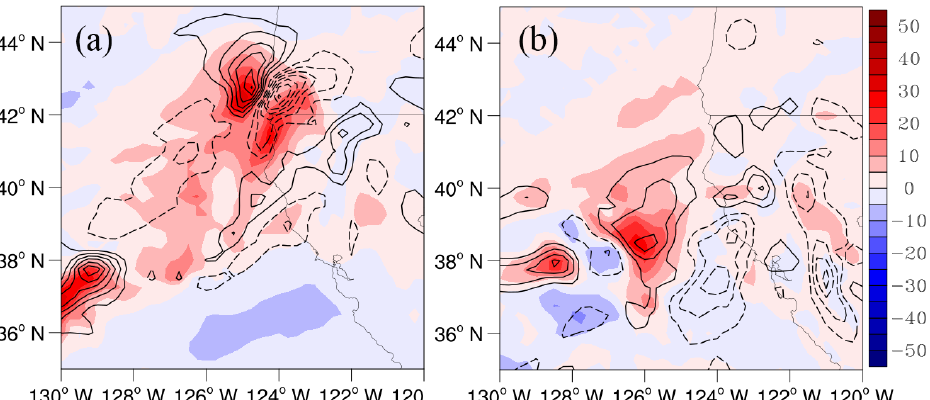
Figure 9. Maps of the latent heating term F 2 (shadings; in 10 − 4 m 2 s − 3 ) and vertical velocity ( − ω ∼ 2 ; L contours; in Pa/s) on the mesoscale window averaged vertically from 900 to 300 hPa: ( a ) on 25 February at 10:00 UTC, ( b ) on 26 February at 18:00 UTC. Solid contours represent the ascending motion with an interval of